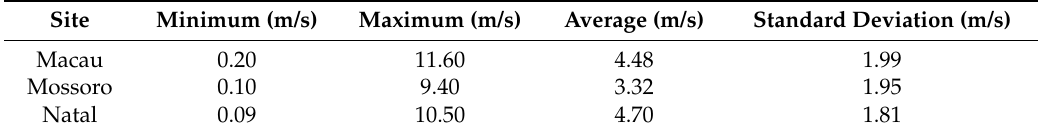
Table 1. Statistics of the wind speed time series from Macau, Mossoro and Natal.